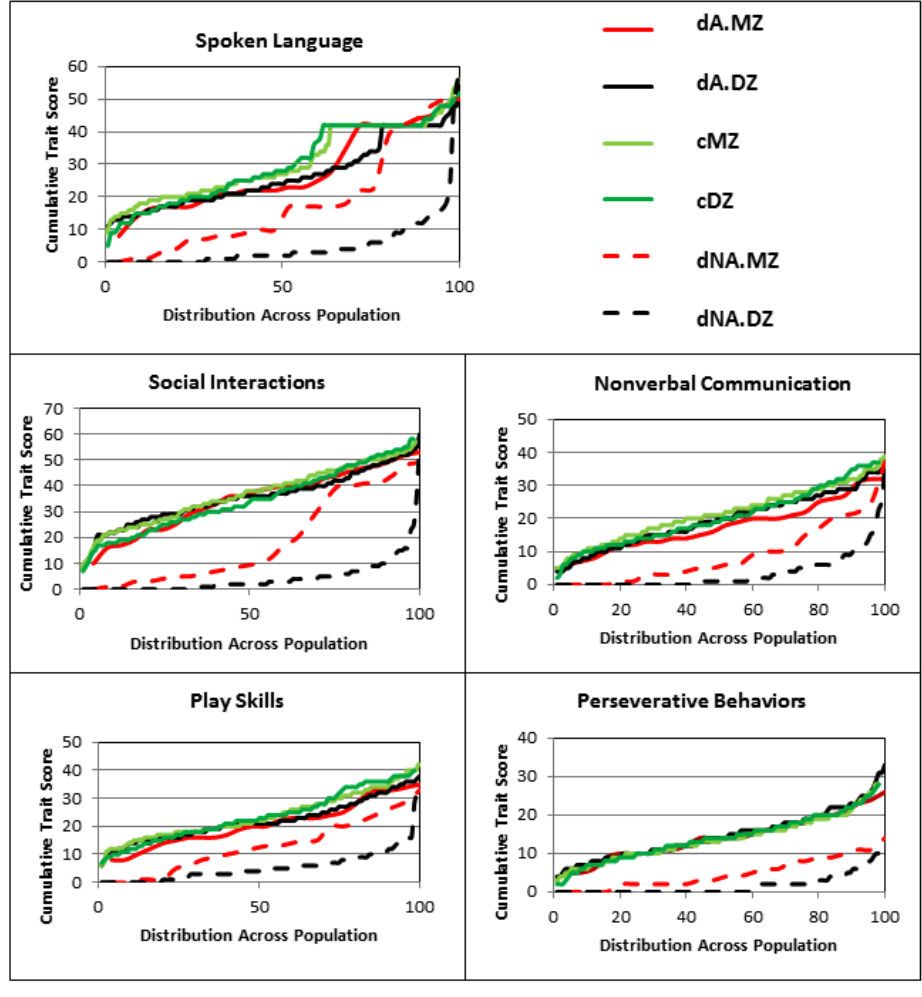
Figure 1. Phenotypic (trait) profiles based on cumulative ADI-R scores for spoken language, nonverbal communication, play skills, social skills / interactions, and perseverative behaviors. In order to better compare the distribution of traits in each twin subgroup, the total number of individuals comprising each group was normalized to 100. The concordant autistic monozygotic (MZ) and dizygotic (DZ) twin subgroups are identified as cMZ and cDZ, respectively, and the discordant autistic (dA) and non-autistic (dNA) MZ and DZ twin subgroups are referred to as dA.MZ, dA.DZ, dNA.MZ, and dNA.DZ, respectively.